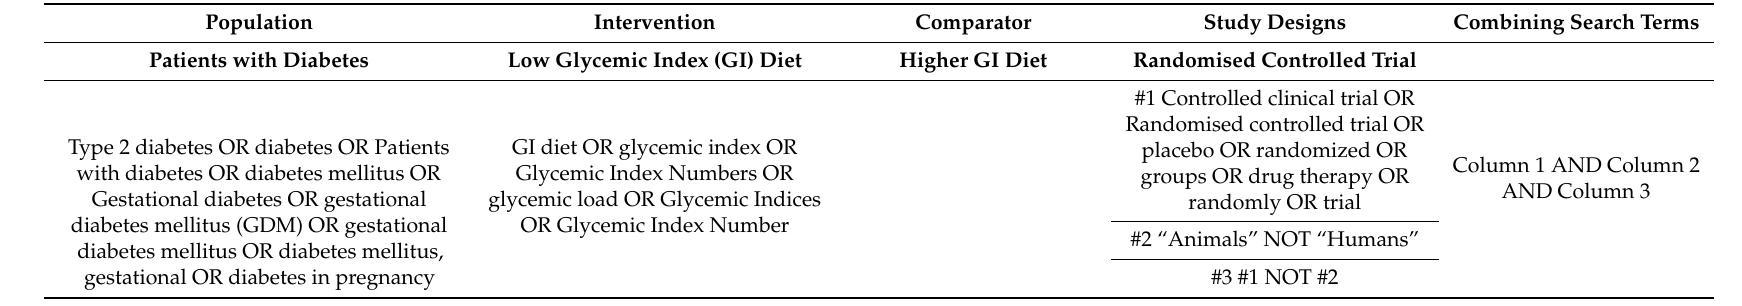
Table 1. Search Strategy and Search Terms.